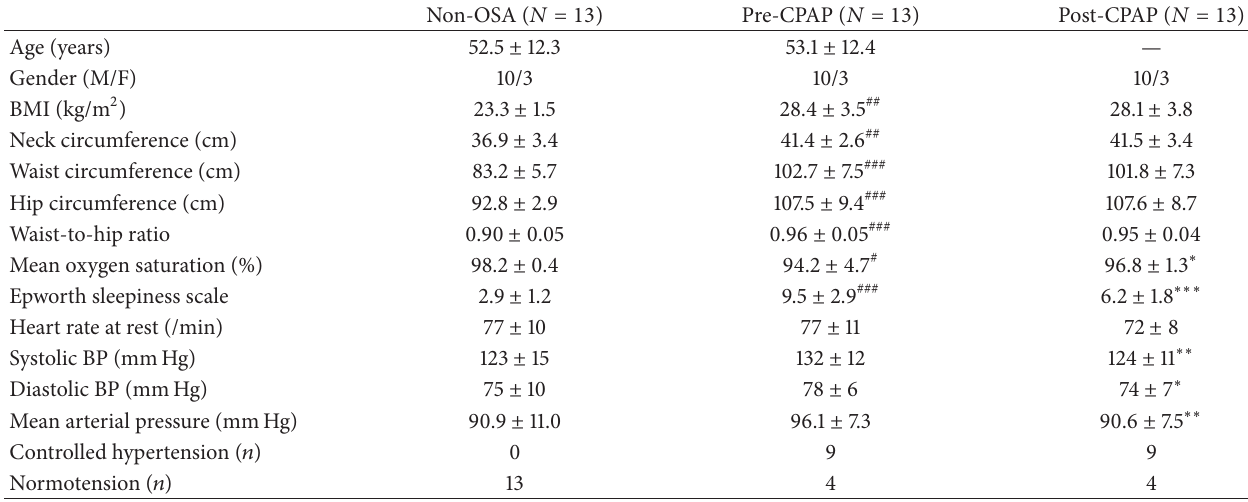
Table 1: Demographic data in OSA patients pre- and post-CPAP therapy and non-OSA controls.